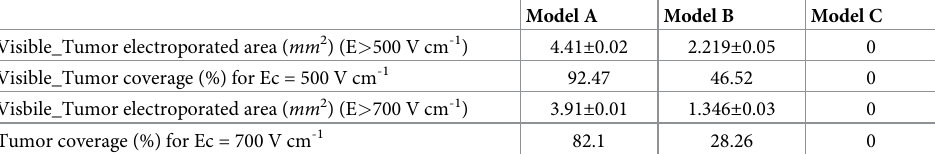
Table 3. Simulated tumor sections electroporated. Simulations results for two electroporation thresholds for the three scenarios are shown: e-biopsy needle in the center of the tumor (Center, Model A), e-biopsy needle at the dis- tance of 0.5mm from the visible tumor margin (Margin, Model B), and e-biopsy needle at the distance of 10mm (Healthy brain, Model C). The simulations assume electric tissue conductivities of fully electroporated tissues: